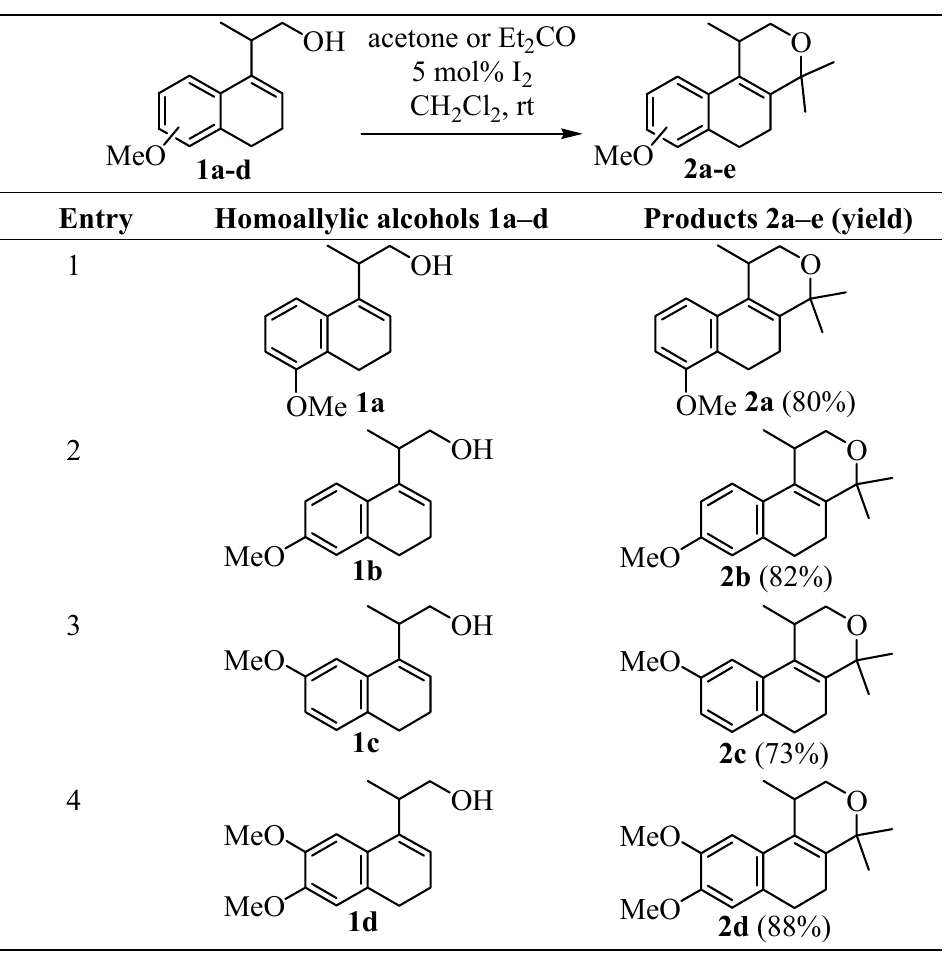
Table 1. Iodine-catalyzed Prins cyclization.